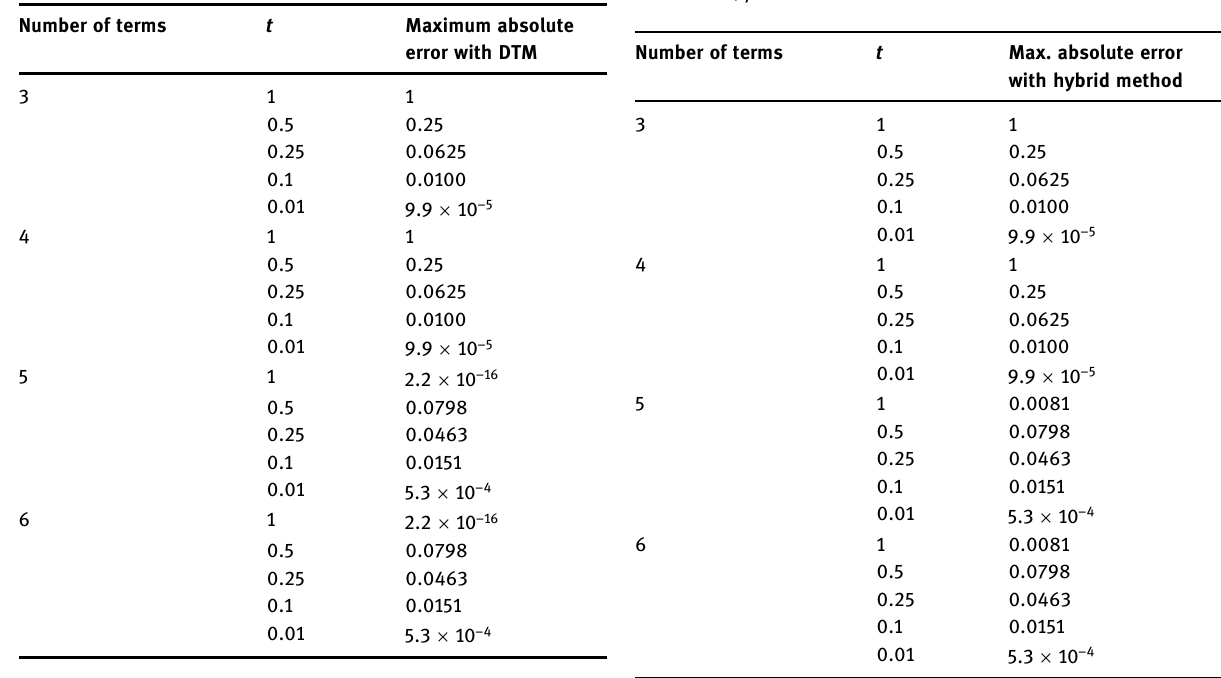
Table 3: The error with respect to “ t ” value and the number of terms in the approximate solution by DTM for 21 21 ∗ mesh and ρ 0.4 =